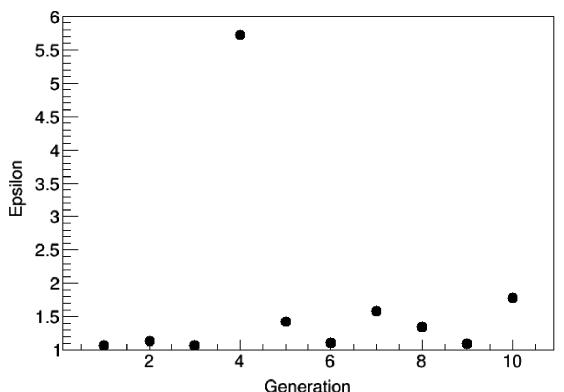
ffiffiffiffiffiffiffiffi p ϵ = σ